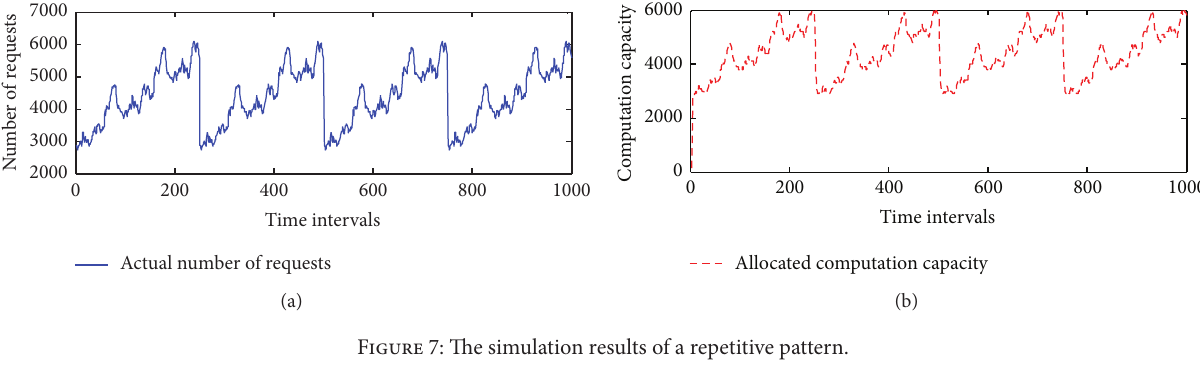
Figure 7: The simulation results of a repetitive pattern.